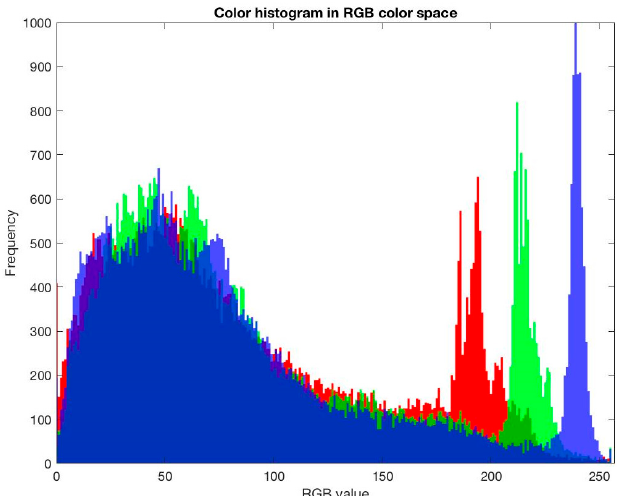
Figure 7. R.G.B. histogram that illustrates the colour frequency and intensity by RGB value .